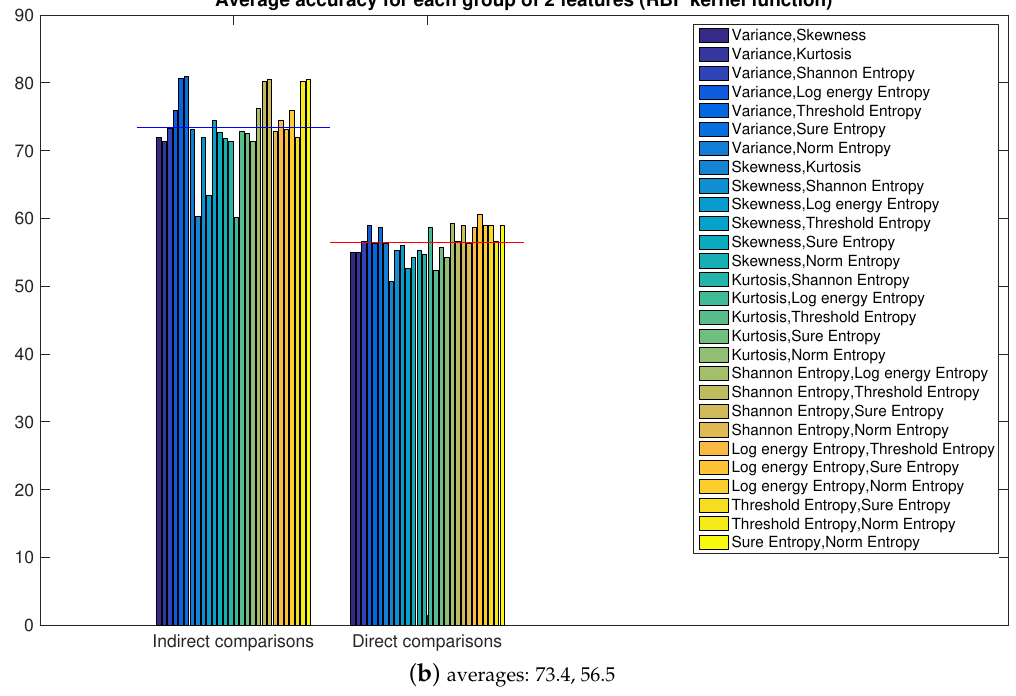
Figure 6. Accuracy and average accuracy for groups of two features (Radial Basis Function (RBF) kernel function, sigma 1.6).